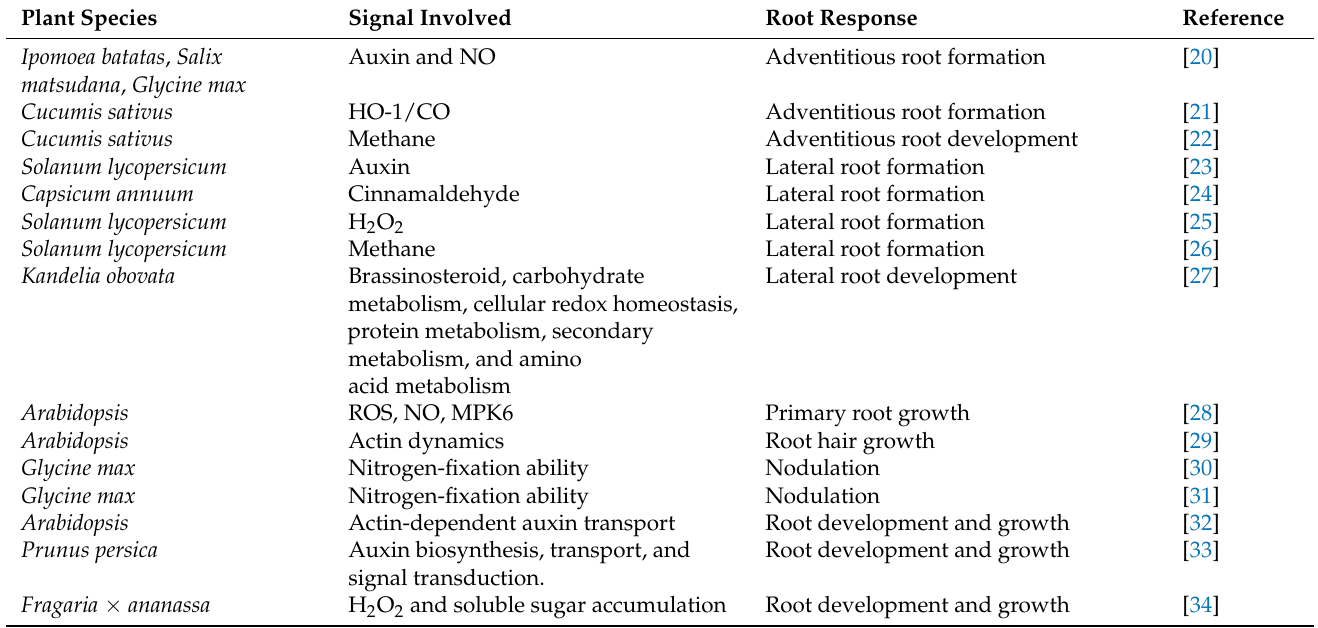
Table 1. The role of hydrogen sulfide in root during development and its interaction with other